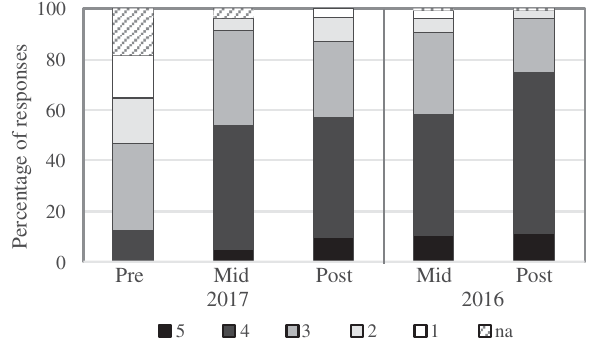
FIG. 7. The distributions across the representational competence levels for the pre-, mid-, and post-test responses for the 2016 and 2017 data. Levels 1 and 2 correspond to perceptual, level 3 to syntactic and levels 4 and 5 to semantic use of representations. Code na was used for responses with no